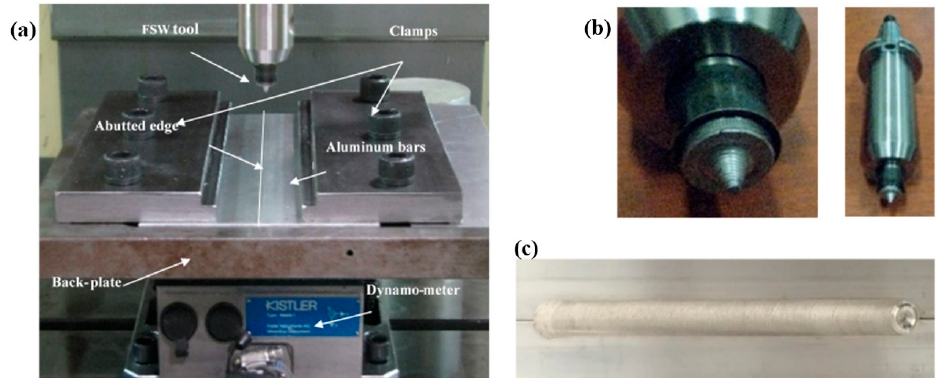
Figure 1. ( a ) The set-up of welding consist of the extruded bars, the clamping system, and the Kistler 3-axis dynamometer; ( b ) friction stir welding (FSW) tool and tool holder; ( c ) top view of the welded sample by optimized process parameters [12].